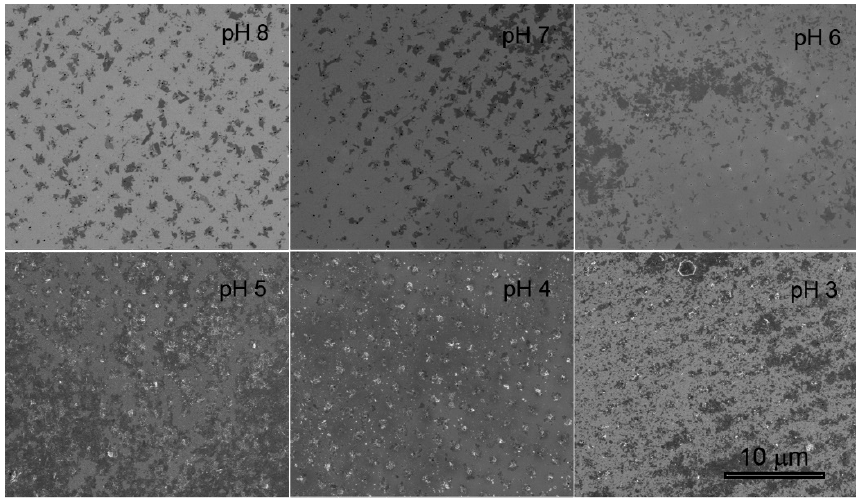
Figure 2. EPD of WS 2 suspended in MEF with di ff erent